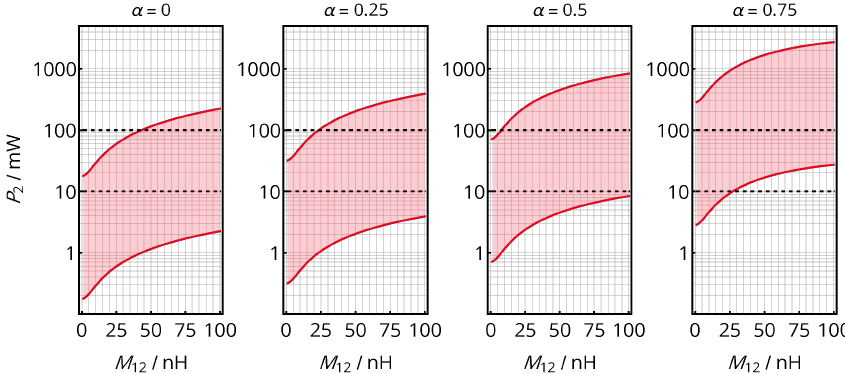
Figure 4. Power bands in which an optimal matching to the load R L,2,opt,SM ( M 12 ) is possible for an limited voltage range [ ˆ U rect,min , ˆ U rect,max ] (here, [ 1V,10V ] ). The compensation ratio α allows adapting the power band to the needs of the load